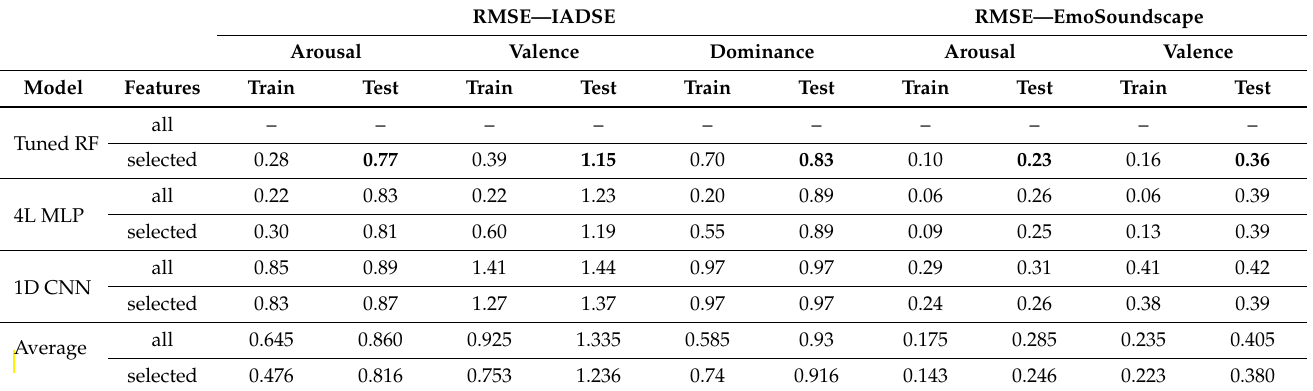
Table 7. Comparing the ensemble model with deep